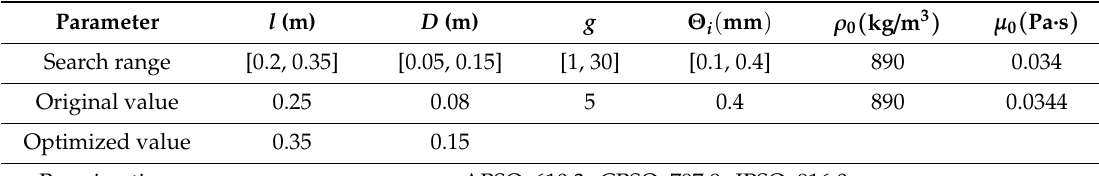
Table 4. Parameter information used in Figure 7.